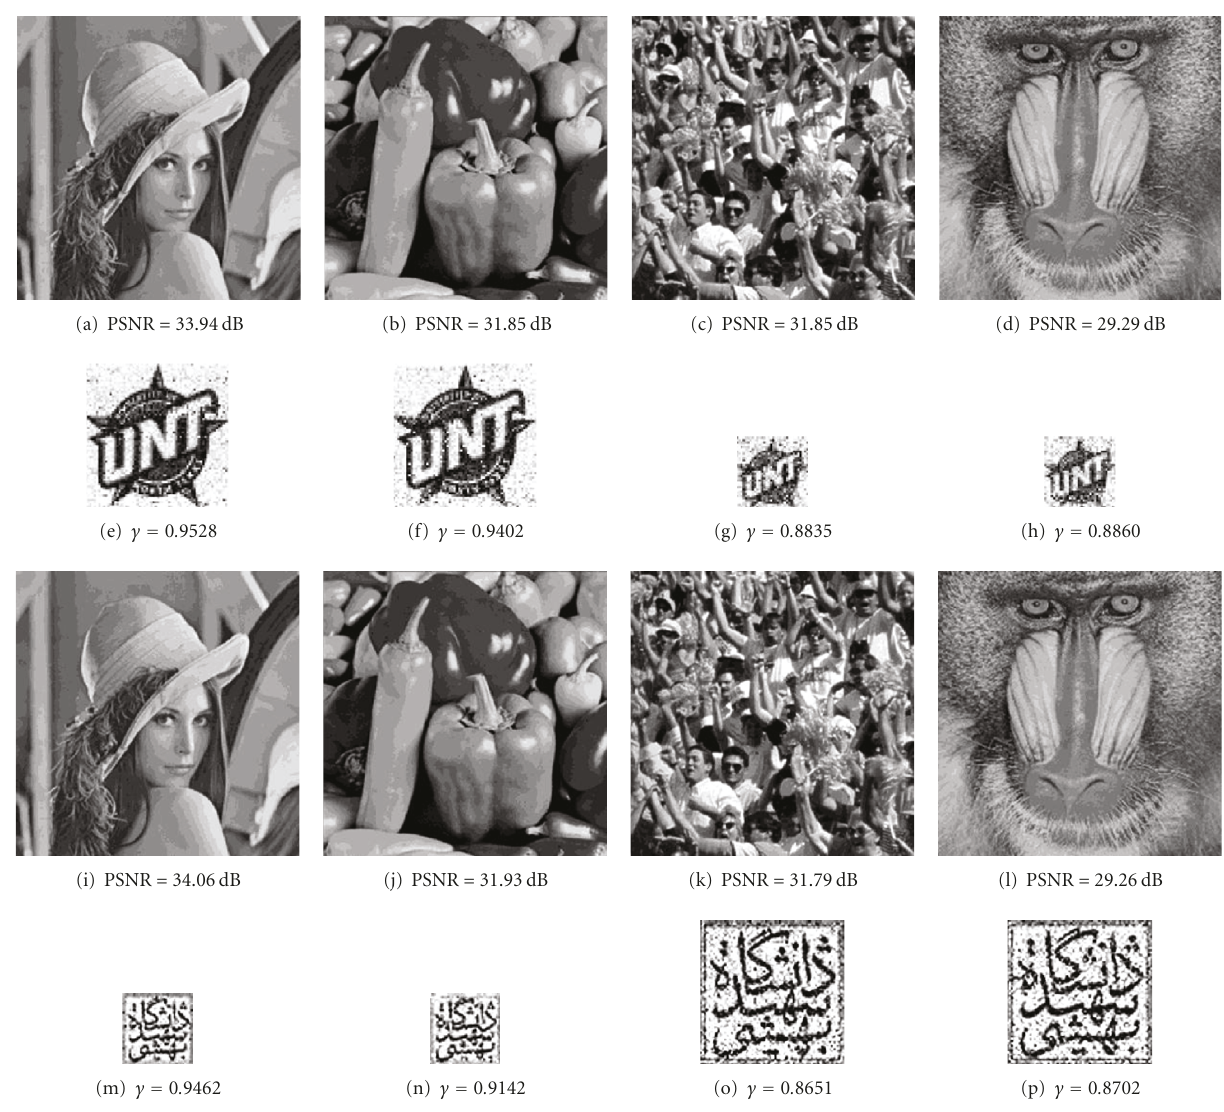
Figure 23: (a) and (b) Lena and Peppers watermarked images with 256 × 256 watermark image as shown in Figure 11(b) after Scaling (1/2), (e) and (f) the extracted watermarks with size 256 × 256 from (a) and (b), respectively. (c) and (d) Crowd and Baboon watermarked images with 128 × 128 watermark image as shown in Figure 11(b) after Scaling (1/2), (g) and (h) the extracted watermarks with size 128 × 128 from (c) and (d), respectively. (i) and (j) Lena and Peppers watermarked images with 128 × 128 watermark image as shown in Figure 11(d) after Scaling (1/2), (m) and (n) the extracted watermarks with size 128 × 128 from (i) and (j), respectively. (k) and (l) Crowd and Baboon watermarked images with 256 × 256 watermark image as shown in Figure 11(d) after Scaling (1/2), (o) and (p) the extracted watermarks with size 256 × 256 from (k) and (l),